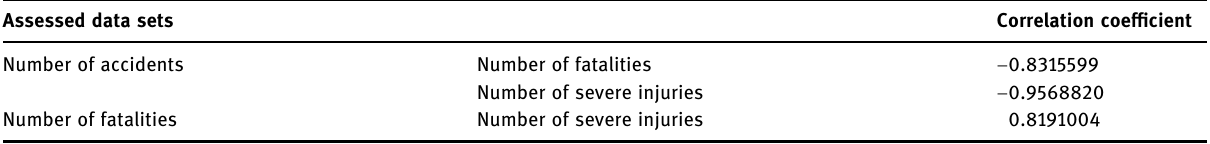
Table 2: Correlation coe ffi cients of selected data sets Assessed data